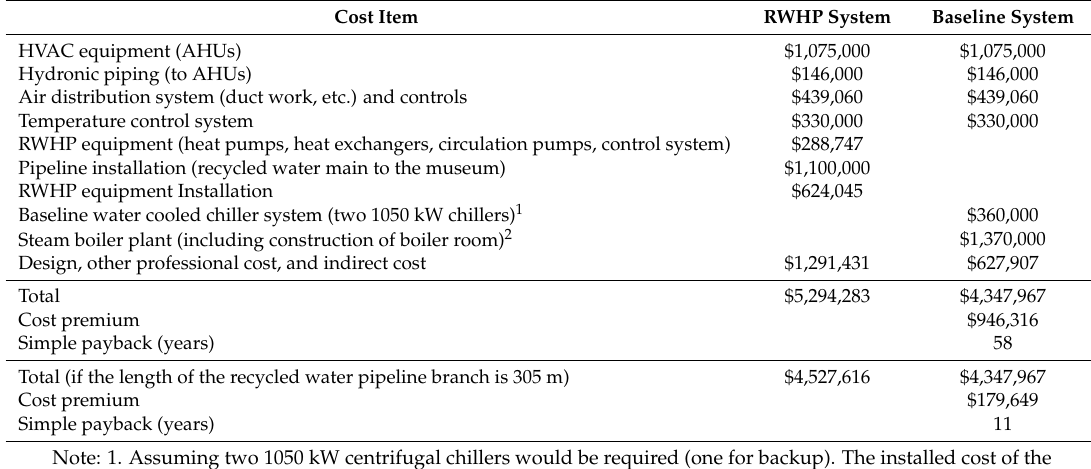
Table 4. Cost effectiveness of the recycled water heat pump system compared with the baseline